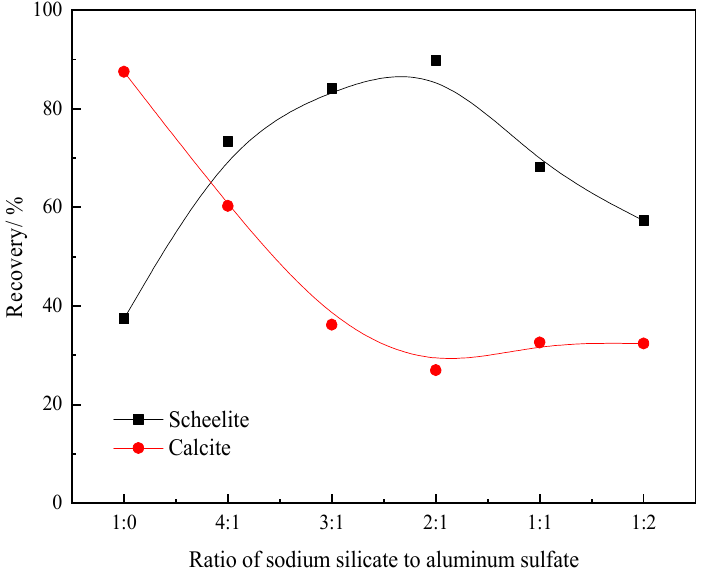
Figure 2. Effect of the ratio of sodium silicate to aluminum sulfate on scheelite and calcite flotation (pH = 8.0 ± 0.1, C ss = 100mg/L, C lead ion = 3 × 10 − 4 mol/L, C BHA = 1.5 × 10 − 4 mol/L, C terpineol = 12.5 μ L/L).